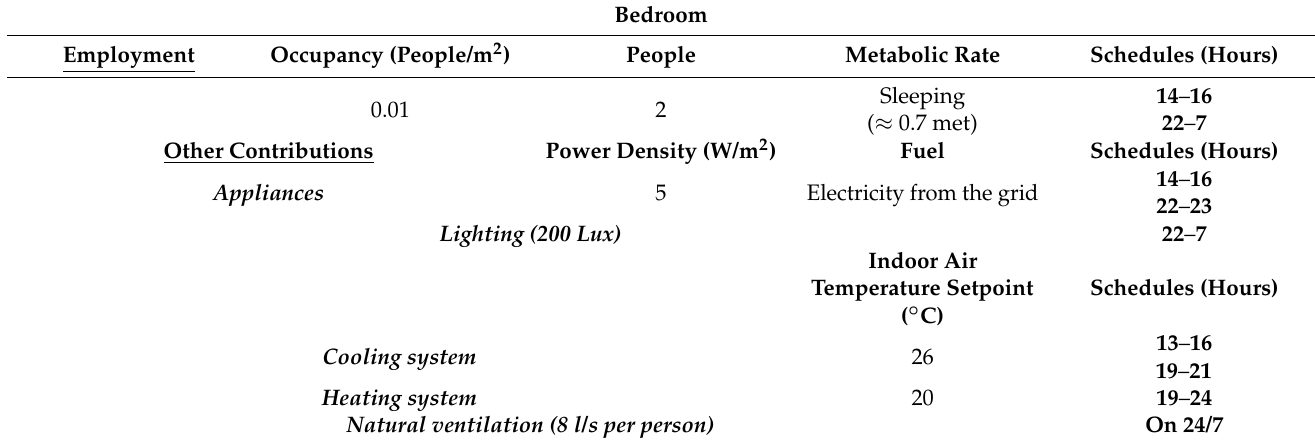
Table 4. Representative schedules for the bedroom